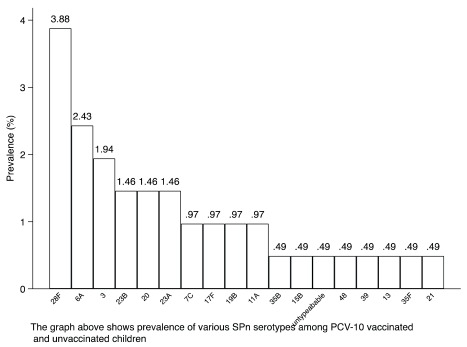
Percentage
S. pneumoniae Serotype Distribution.